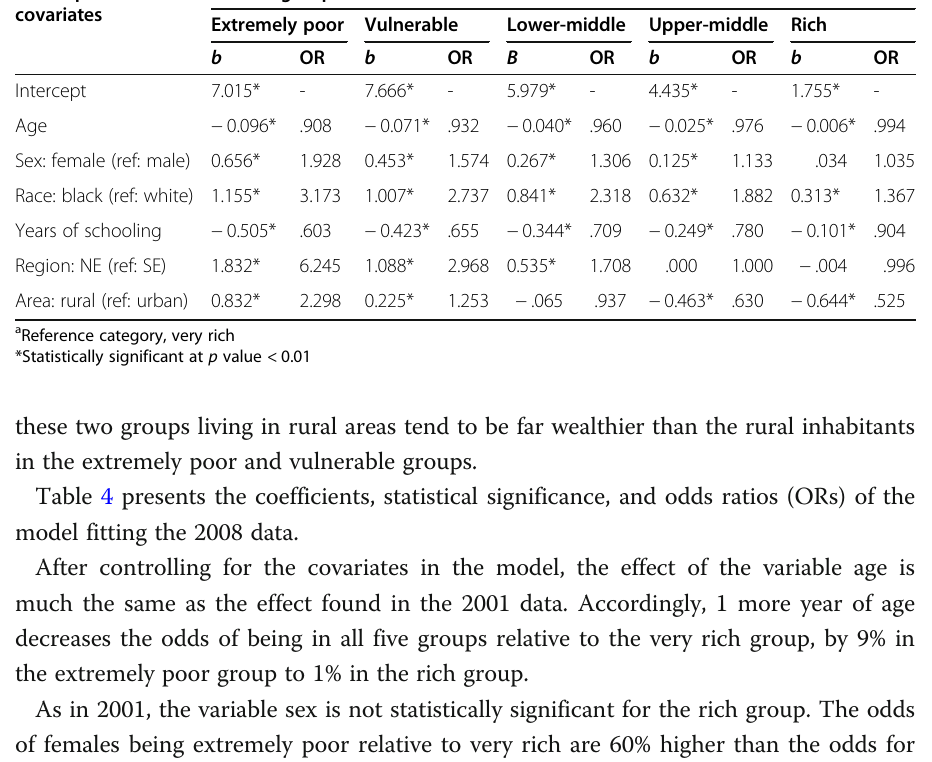
Table 3 Multinomial logistic regression of selected variables on the relative income groups — Northeast (NE) and Southeast (SE) regions, Brazil, 2001 Intercept and Income group a covariates Extremely poor Vulnerable Lower-middle Upper-middle Rich b OR b OR